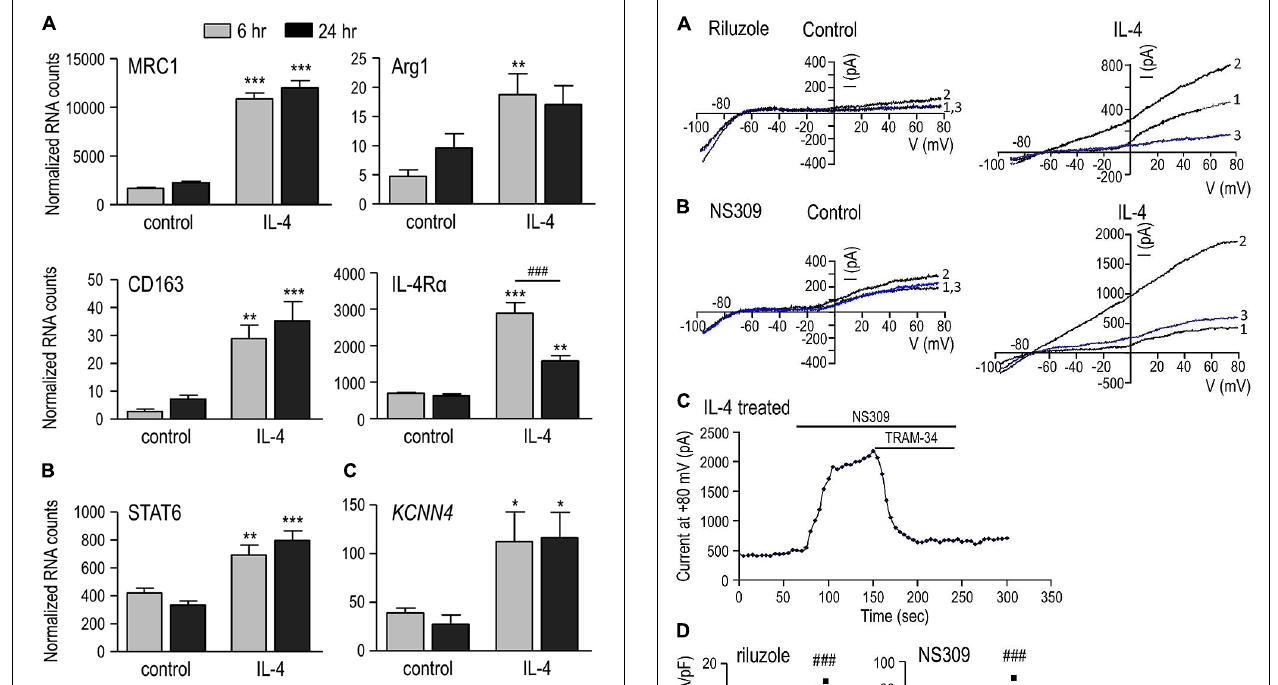
currents (traces labeled “2”). As is diagnostic of KCa3.1, the cur- rent was present at all voltages tested ( − 100 to + 80 mV), reversed near the K + Nernst potential, and was substantially blocked (aver- age of 95%, n = 14) by 1 μ M TRAM-34 (traces labeled “3”). [The current with riluzole + TRAM-34 ( Figure 2A , trace “3”) was smaller than the control (trace “1”) because riluzole also inhibits Kv1.3 (Bellingham, 2011).] An example of the time course of cur- rent activation by NS309 and block by TRAM-34 is shown in Figure 2C . KCa3.1 currents were evoked by riluzole in 4/4 cells, by NS309 in 8/9 cells, and by 1-EBIO in 5/5 cells (not illus- trated). The mean amplitude of the TRAM-34-sensitive